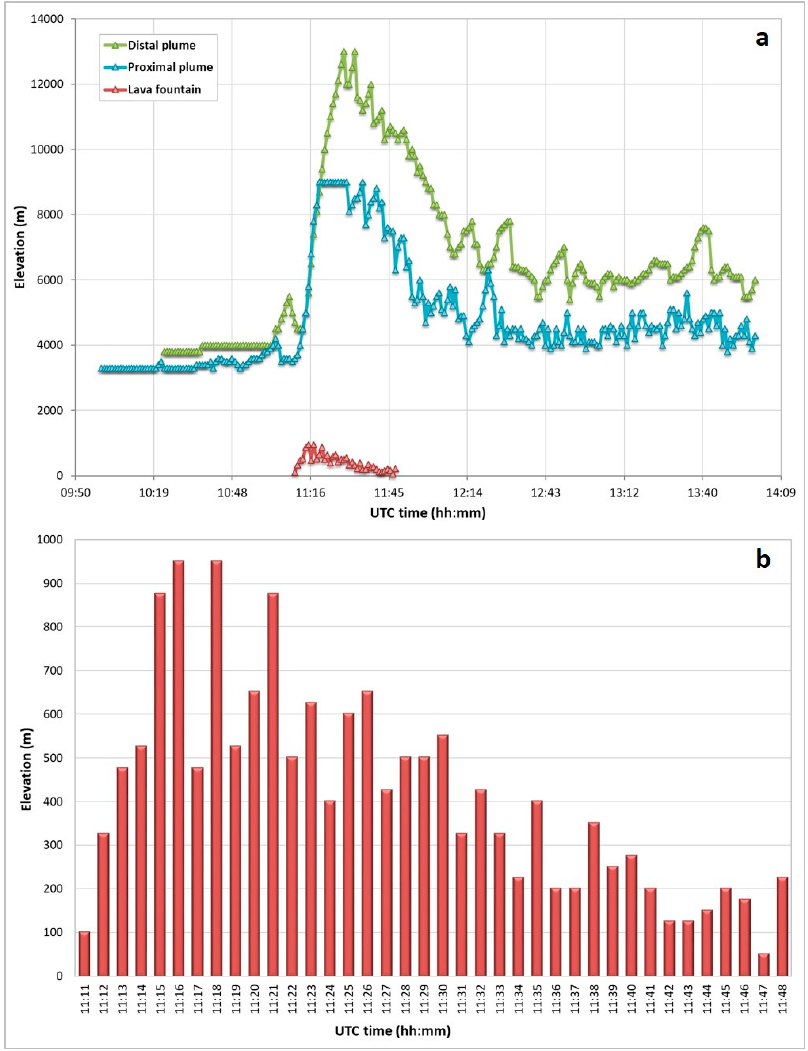
Figure 5. ( a ) Elevation (in meters above sea level, a.s.l.) of the ash plume retrieved from the calibrated ECV camera (blue triangles) that allows a view of the ash plume up to 9 km a.s.l. and up to ~5 km distance from the craters, and from the non-calibrated ECVH wide-angle camera (green triangles) that allows for a wider perspective and to follow up the spreading of the plume up to an ~15 km distance from the vent against time, compared with the height of the lava fountain from the eruptive fissure (red triangles) obtained from the ENT camera. The maximum apparent elevation of the distal plume (green triangles) was recorded between 11:29 and 11:33. ( b ) Elevation (in meters above the vent) of the lava fountains occurred at the eruptive fissure against time (UT) recorded between 11:11 and 11:48 on 24 December 2018 from the ENT thermal camera.